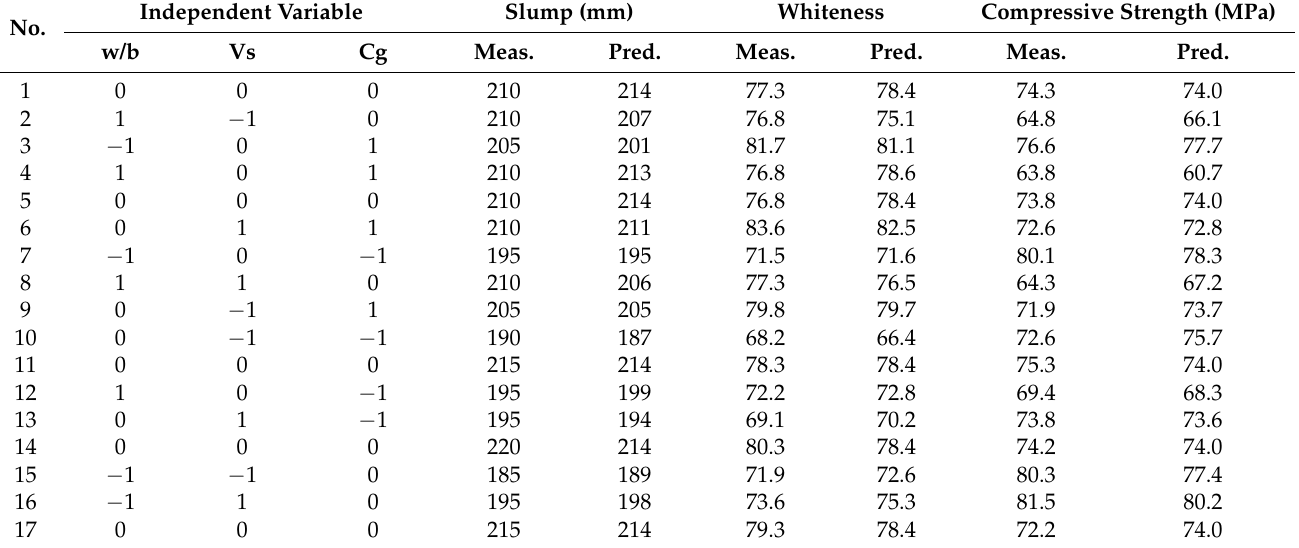
Table 5. Measured (meas.) and predicted (pred.) results.